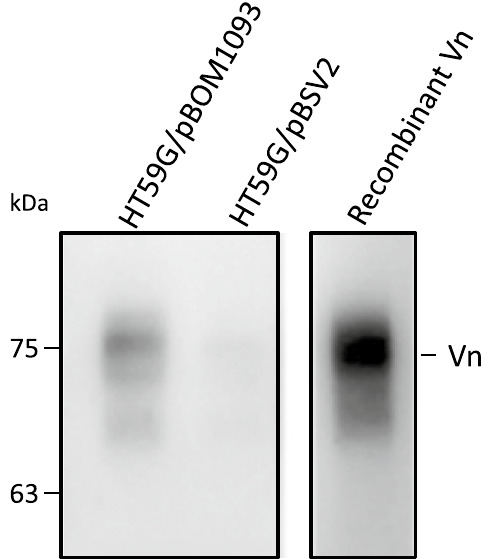
Figure 4. Human serum Vn is co-precipitated with BOM1093. B. garinii HT59G expressed 6xHis-tagged BOM1093 (~ 10 8 cells/tube) were incubated with 20% NHS for 1 h at 37 °C and washed 3 times with Tris–HCl buffer (pH 7.0) containing 5 mM Pefabloc SC. The 6xHis-tagged BOM1093 from sonicated cells was captured using Ni–NTA magnetic beads. The captured proteins were separated on a 10% SDS-PAGE gel, transferred to PVDF membrane, and Vn was detected by western blotting. B. garinii HT59G/pBSV2 was used as a Mock control.